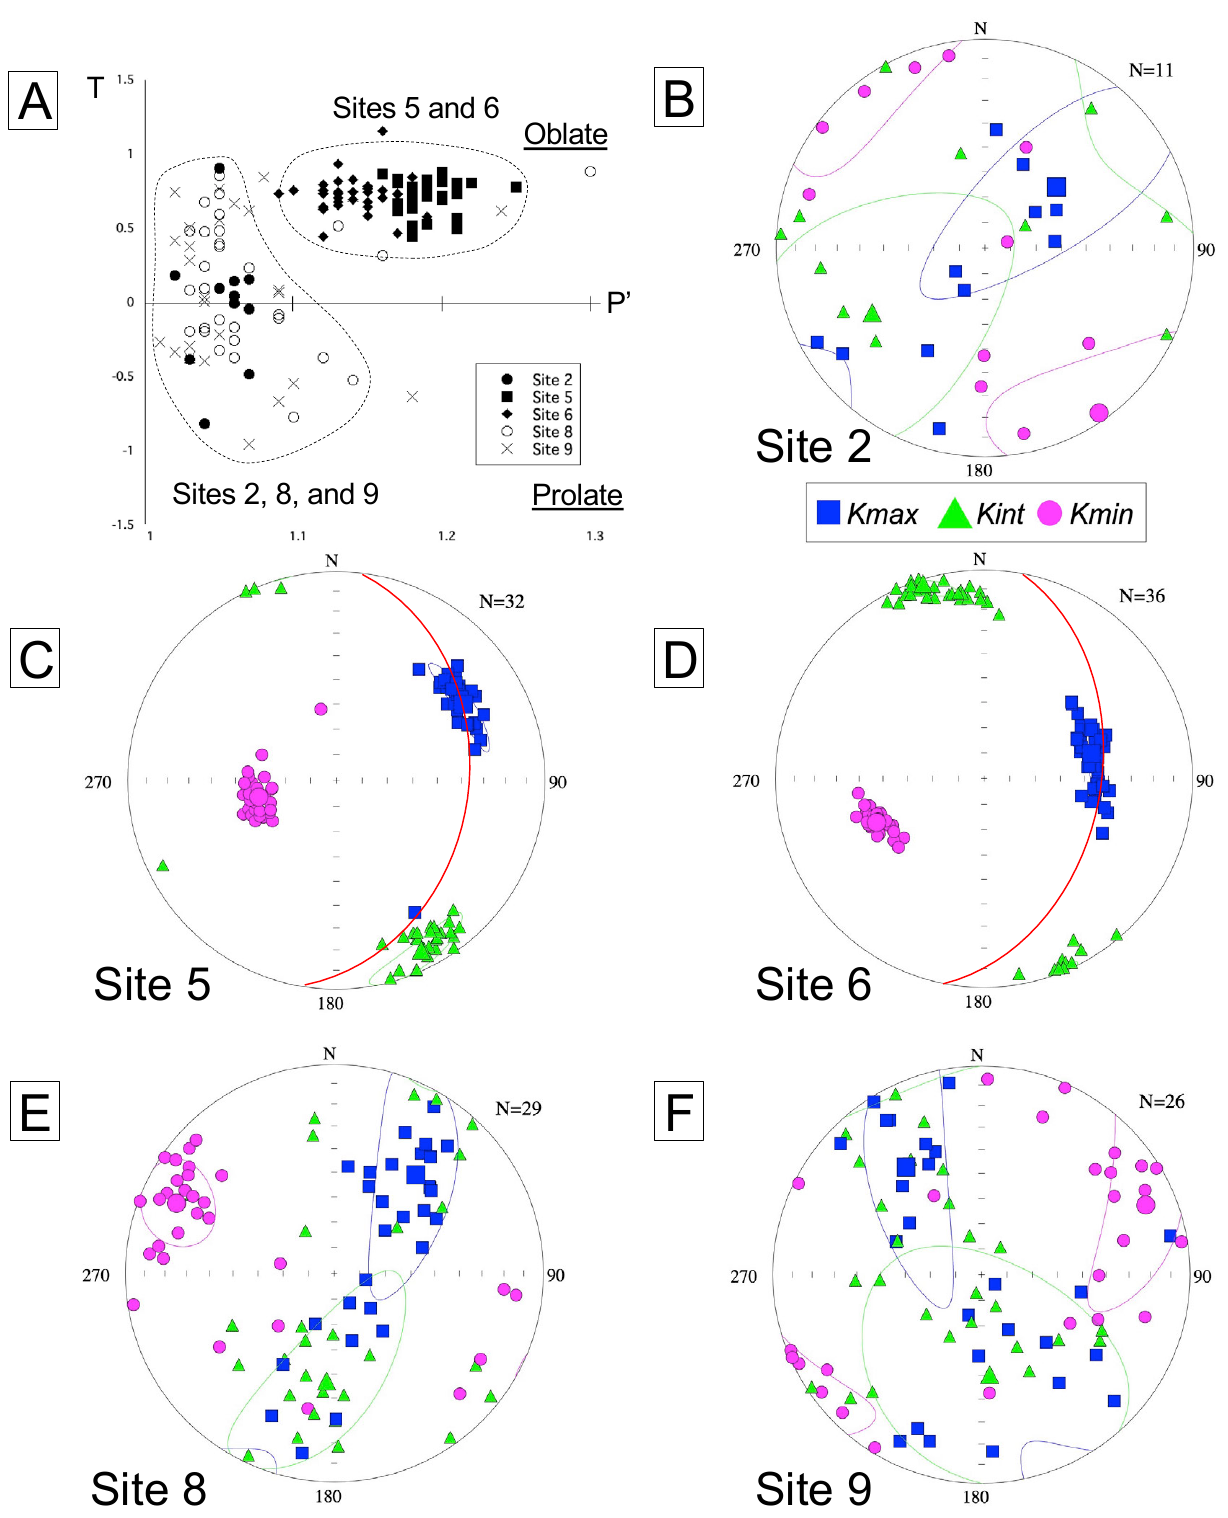
Figure 18: [A] Plot of the AMS shape parameter (T) against the degree of anisotropy (P’) of the five sites. [B-F] Orientation of the principal susceptibility axes of all the specimens. Solid squares, triangles, and circles represent the maximum, intermediate, and minimum axes, respectively. Great circle in sites 5 and 6 shows the foliation planes developed in the